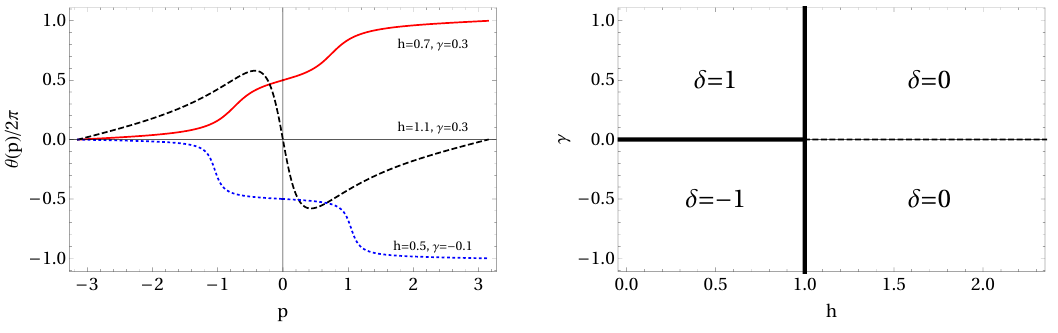
Figure 1: (left panel): the dependence of Bogoliubov angles on momentum for three different points in h − γ -plane: h = 0.7, γ = 0.3 ( δ = 1) – red solid, h = 1.1, γ = 0.3 ( δ = 0) – black dashed, h = 0.5, γ = − 0.1 ( δ = 0) – blue dotted; (right panel): three regions in h − γ -plane corresponding to δ = ± 1 (ferromagnetic phase with γ ≷ 0) and δ = 0 (paramagnetic phase ).